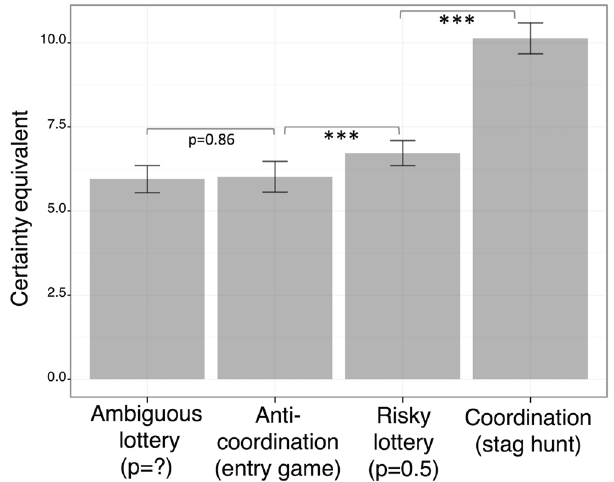
Figure 3. Average certainty equivalents across decision environments. For each participants and each decision environment, certainty equivalents were computed. Error bars represent standard error of the means. Asterisks represent significance levels of paired Wilcoxon signed-rank tests: *** p < 0.001.